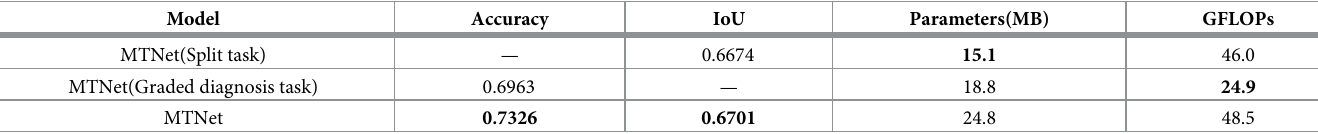
Table 6. The experimental results of